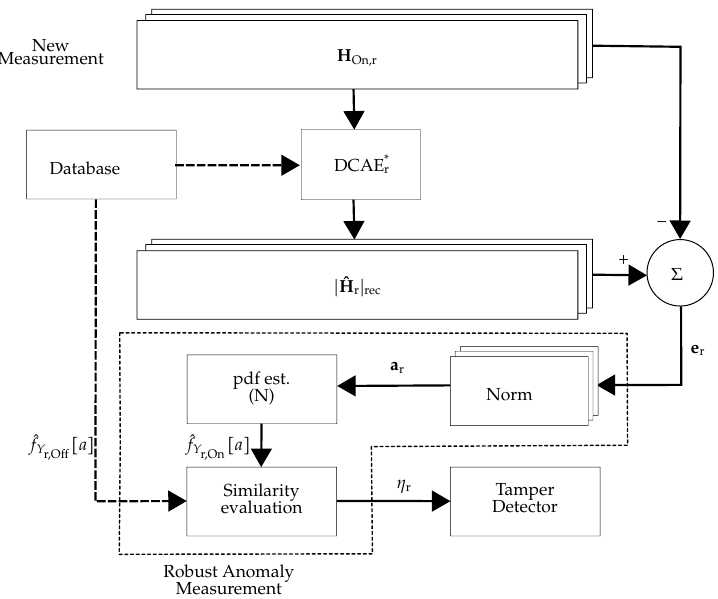
[ a ] ) and the r,Off